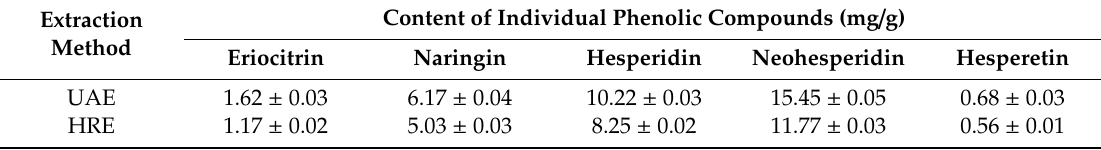
Figure 3. HPLC-DAD chromatogram of the extracts obtained by ultrasonic-assisted extraction under optimized conditions. Peaks 1, 2, 3, 4, and 5 represent eriocitrin, naringin, hesperidin, neohesperidin, and hesperetin, respectively. Table 3. Comparison of individual phenolic compounds contents in CAB extracted by UAE and